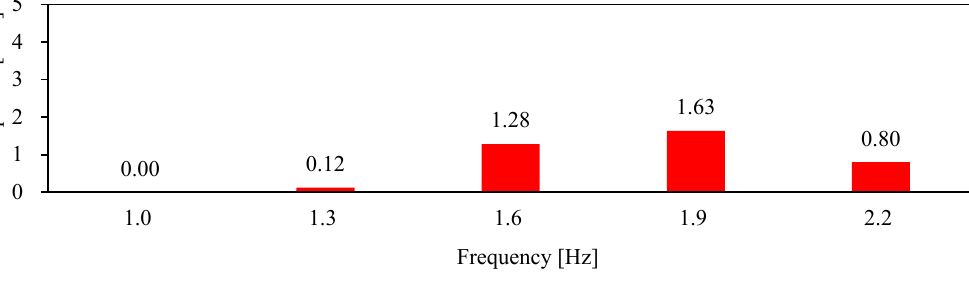
Figure 17. Effect of periodic excitation signal frequency on vibration power generated.